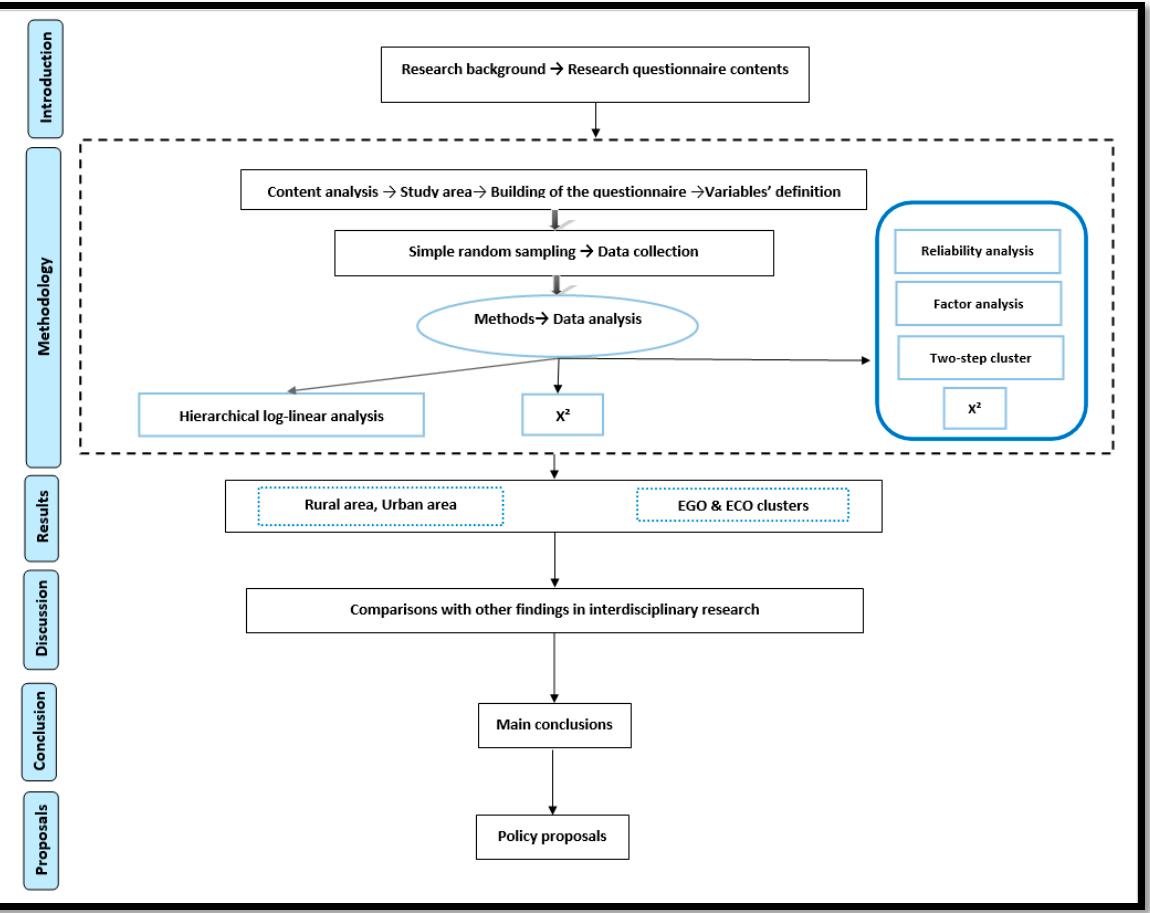
Figure 1. Flow chart of the methodology and study structure.